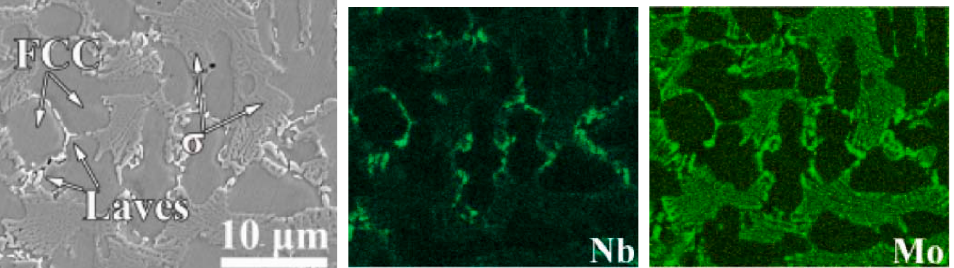
Figure 9. SEM micrograph and respective EDS composition maps for the distribution of Nb and Mo for the Co 26.57 Ni 26.81 Cr 17.71 Mo 7.63 Nb 2.40 B 12.67 Si 6.22 (at.%) HEA deposited by the plasma cladding. Micrograph is reprinted with permission from ref. [95]. Copyright 2022 Elsevier.